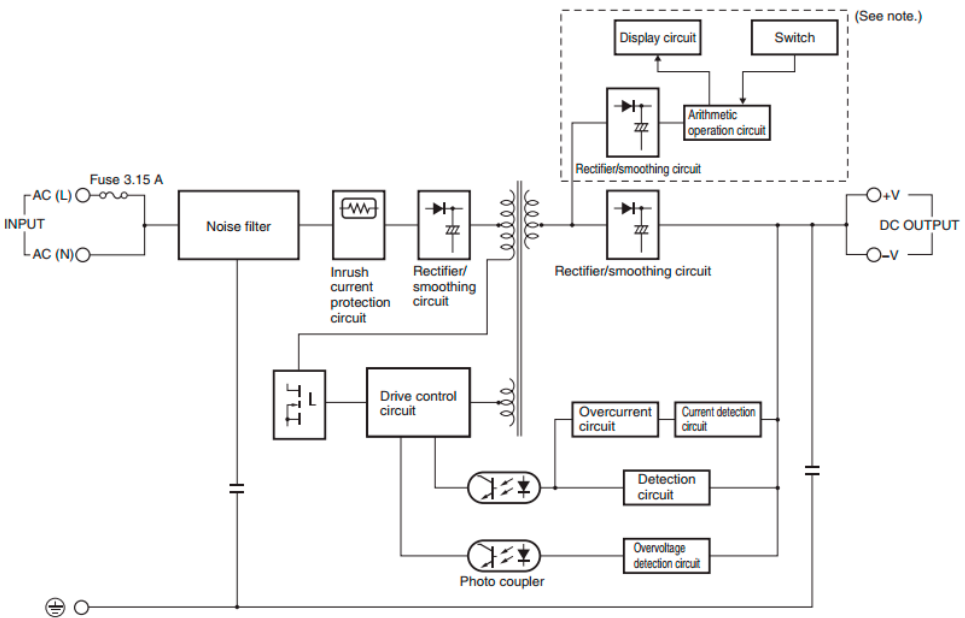
Figure 6. Power supply block diagram.